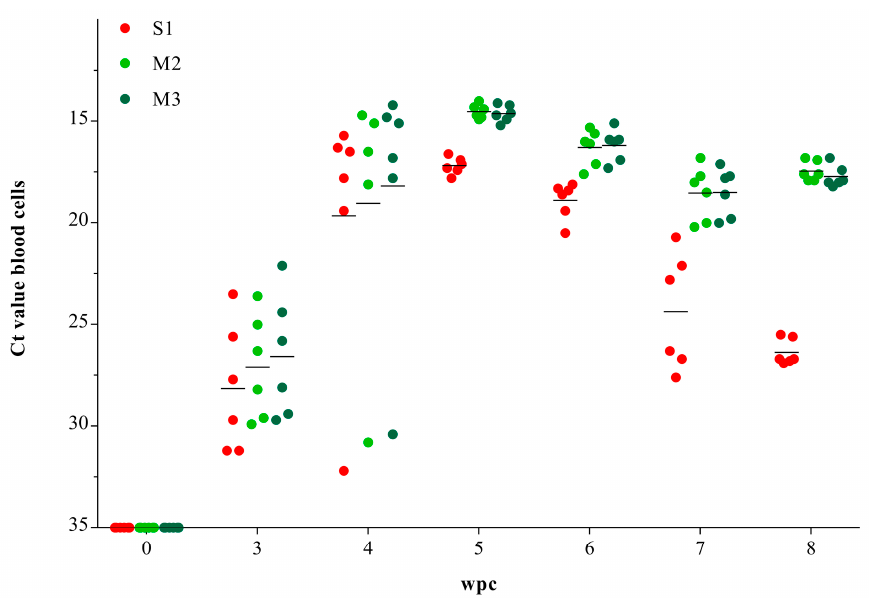
Figure 1. Piscine orthoreovirus (PRV) RNA load in blood cells. Reverse transcription quantitative polymerase chain reaction (RT ‐ qPCR) of PRV gene segments S1, M2 and M3 in blood cells from cohabitant fish. Individual ( dots ) and mean ( line ) Ct ‐ values, n = 6 per time ‐ point. wpc = weeks post challenge.